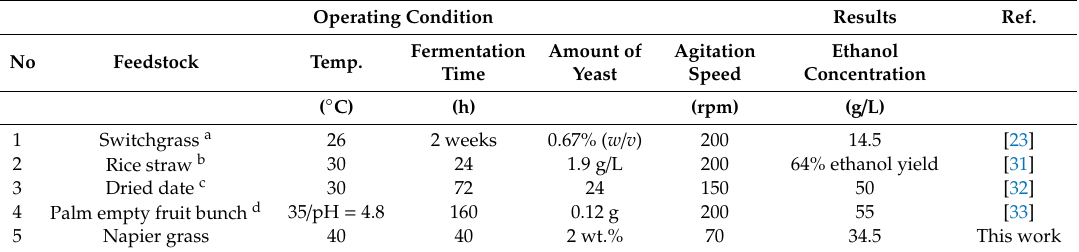
Figure 9. Effect of yeast amount on the fermentation of treated Napier grass using a four - blade turbine impeller at 30 °C and an agitation speed of 70 rpm .